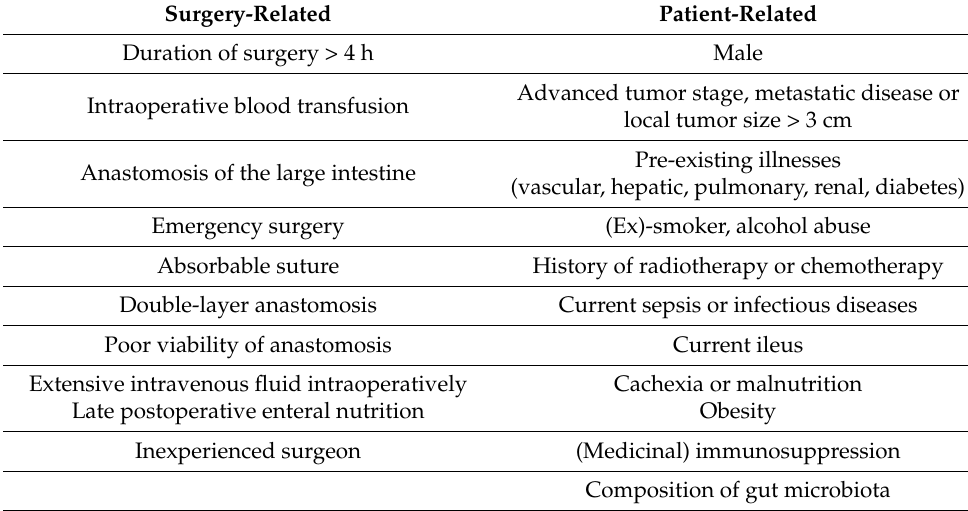
Table 1. Factors contributing to or increasing the risk of postoperative anastomotic leakage,